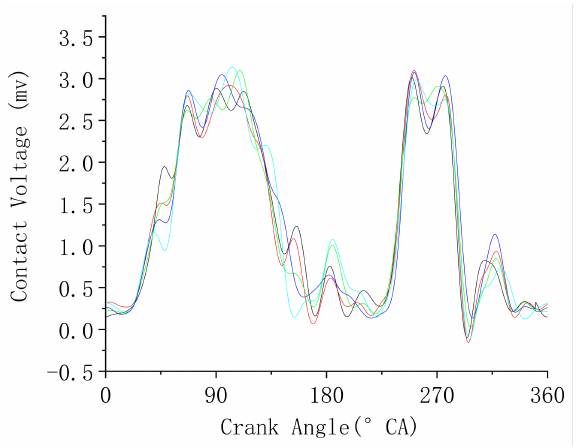
Figure 9. CV signal of copper alloy bearing (1500 r/min, 10